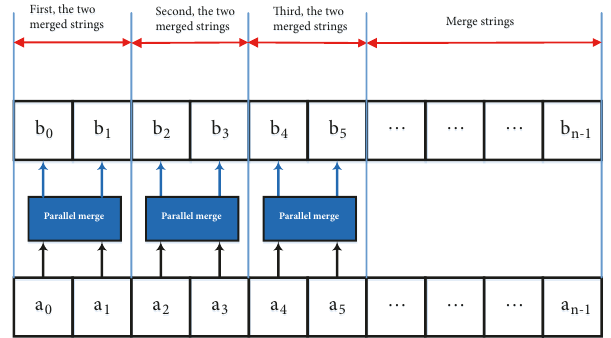
Figure 6: The first step of the proposed flexible parallel merge sort, when the algorithm merges elements of the input strings in pairs.